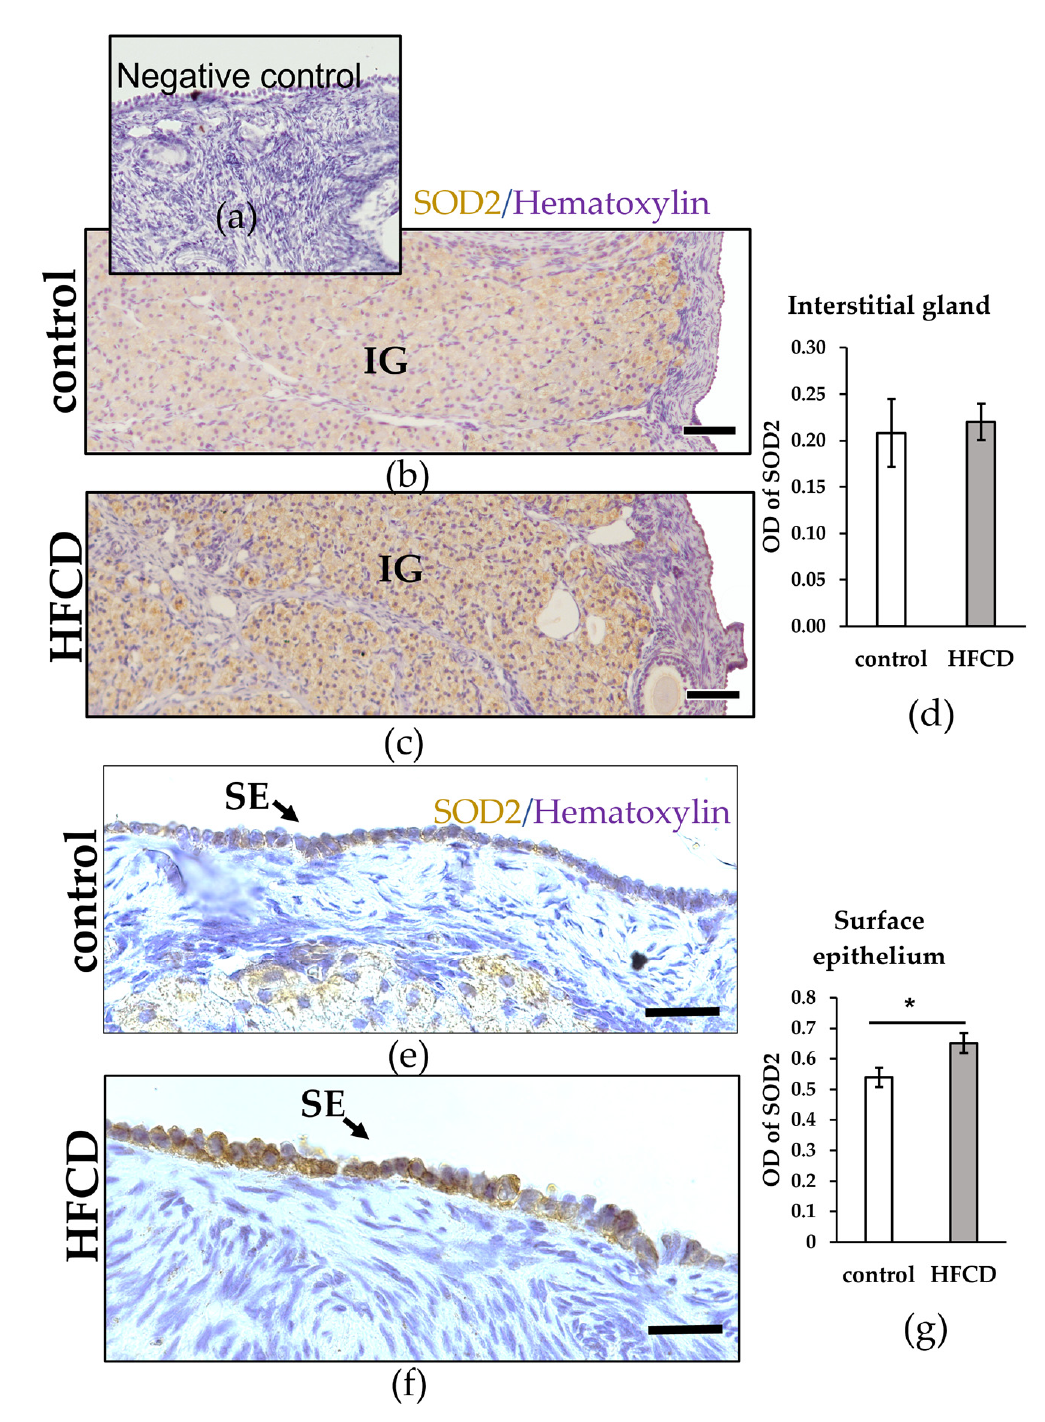
Figure 3. SOD 2 protein localization and levels in ovaries. ( a ) Negative control without primary antibody; no signal detected. Immunochemical localization (brown) in the ovarian interstitial gland ( b , c ) and surface epithelium ( e , f ) of chinchilla rabbits, fed with either a control diet or with HFCD. The nuclei are stained with hematoxylin (blue). Scale bars: ( b , c ), 100 µ m; ( e , f ), 25 µ m. ( d , g ) Densitometric quantification performed on immunohistochemical localization of SOD 2 of ovarian sections of chinchilla rabbit fed with either a control diet or with HFCD. Data are expressed as mean ± ESM * p < 0.05.